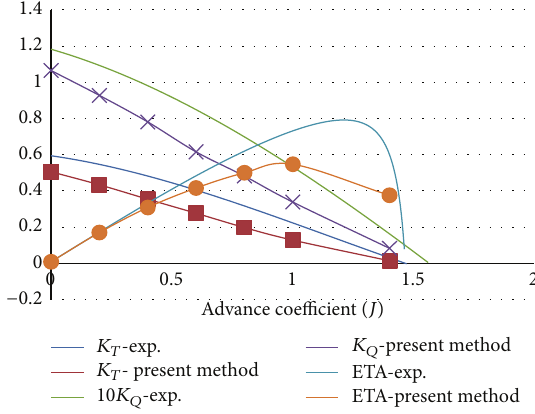
Figure 7: Hydrodynamic coefficient of the investigated propeller with 𝑃/𝐷 = 1.4 .